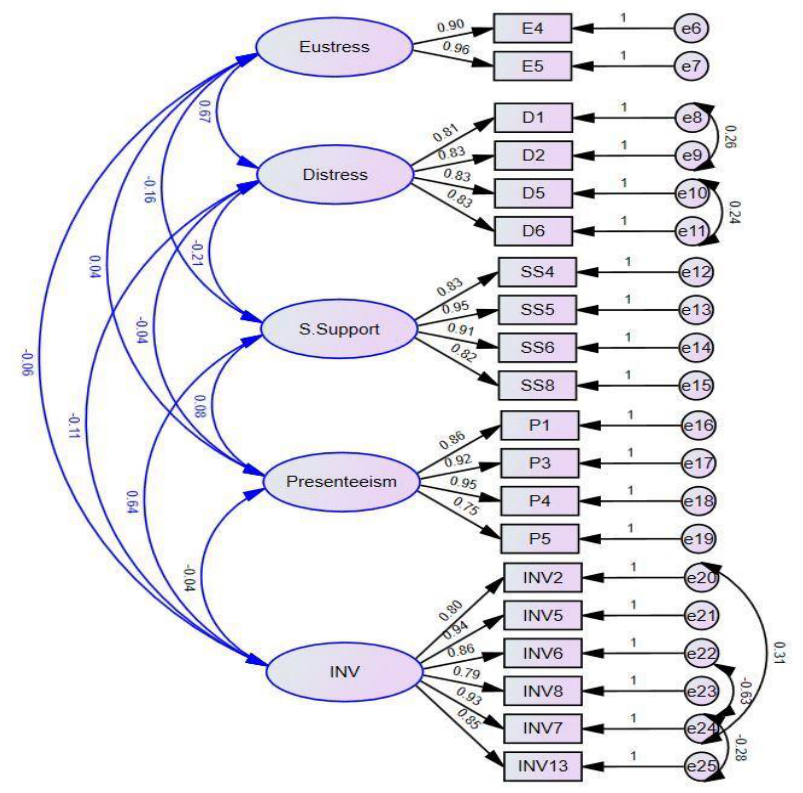
Figure 2. Confirmatory factor analysis. Table 5. Model